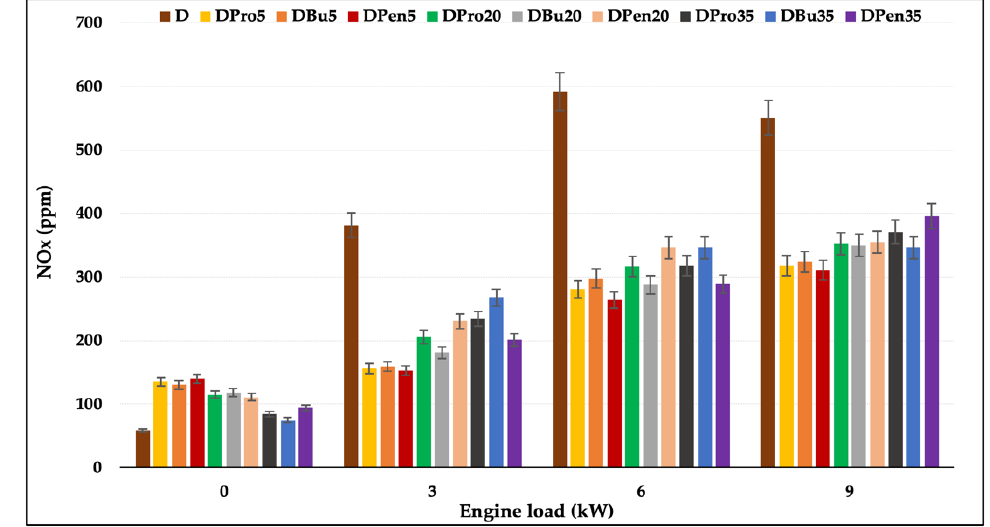
Figure 2. Comparison of NO x emissions with engine load for test fuels.